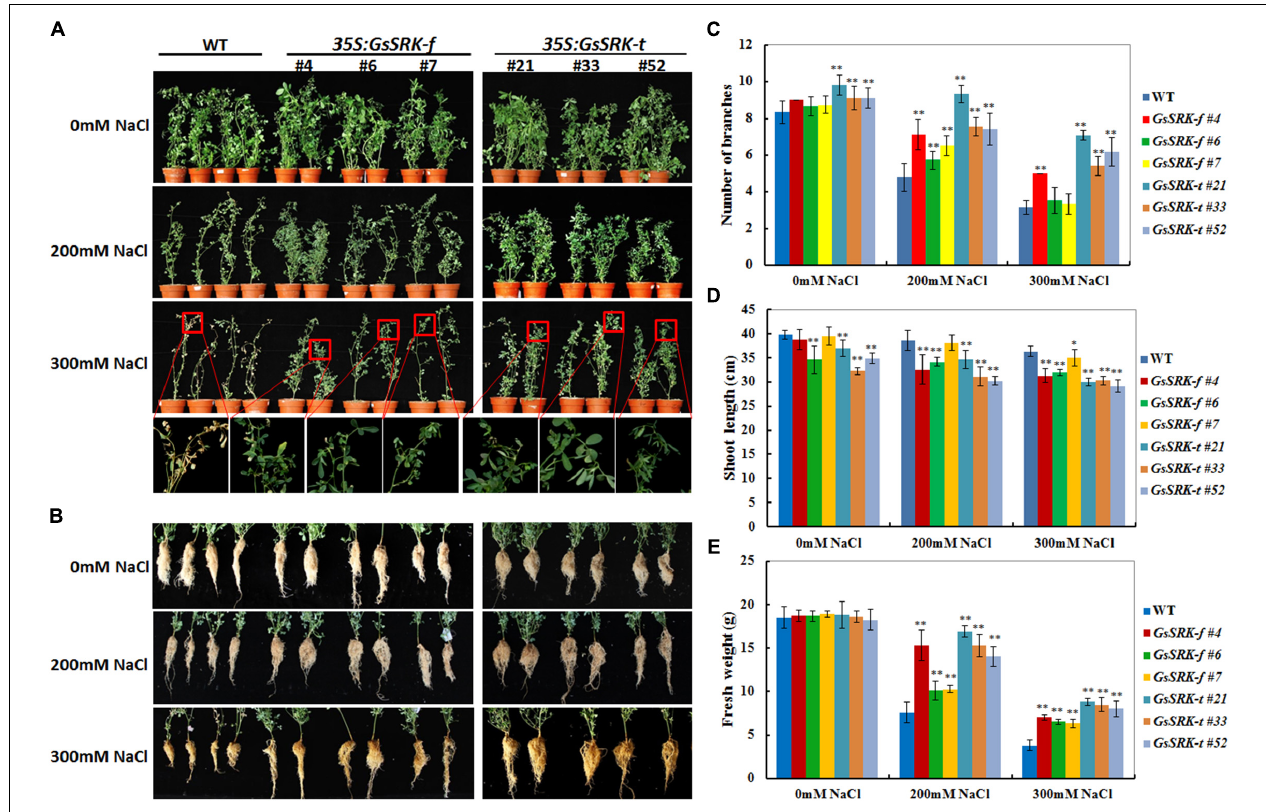
FIGURE 4 | GsSRK-f and GsSRK-t overexpression in alfalfa contributes to increased salt tolerance. (A) Shoot growth performance of the WT and transgenic alfalfa under salt stress. (B) Root growth performance of the WT and transgenic alfalfa under salt stress. The WT and transgenic alfalfa seedlings showing similar growth performance were irrigated with 1/8 Hoagland solution containing either 0 or 200 or 300 mM NaCl every 2 days for a total of 18 days. (C) Numbers of branches of the WT and transgenic alfalfa under control conditions and salt stress. (D) Shoot length of the WT and transgenic alfalfa under control conditions and salt stress. (E) Fresh weight of the WT and transgenic alfalfa under control conditions and salt stress. Ten seedlings of each line were used for each experiment. Data are means ± SE ( n ≥ 10) of three replicates. ∗ P < 0.05; ∗∗ P < 0.01 by Student’s t